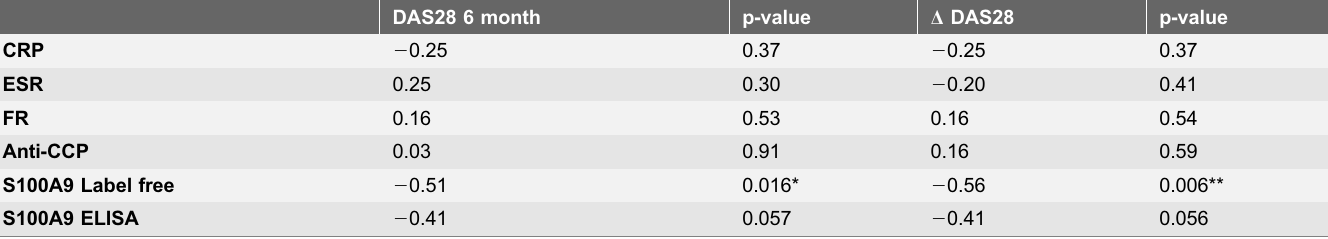
Table 3. Relationship between baseline levels of several potential markers measured prior to MTX/ETA initiation and the degree of response over the 6 months follow-up in the second population. DAS28 6 month p-value D DAS28 p-value CRP 2